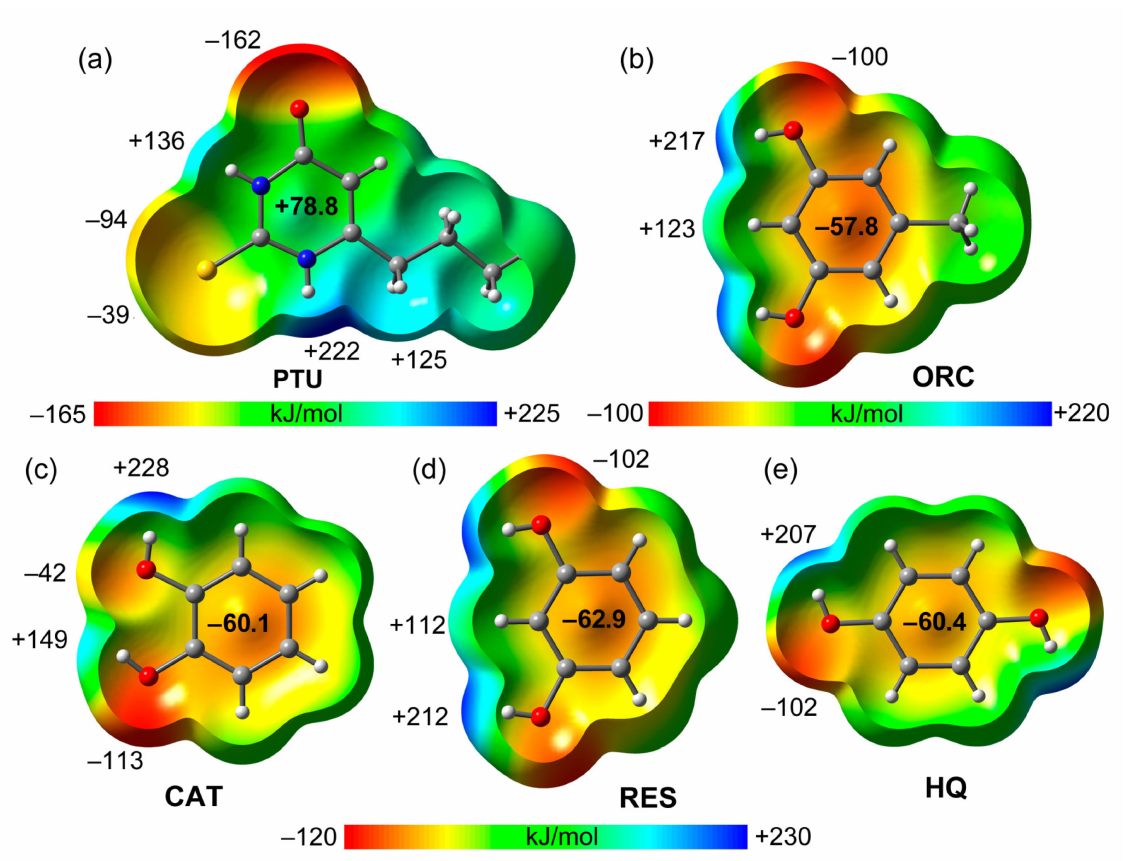
Figure 9. MEP surfaces of the salts of PTU ( a ), ORC ( b ), CAT ( c ), RES ( d ), and HQ ( e ) at the PBE0-D3/def2-TZVP level of theory (density isovalue 0.001 a.u.). The energies are given in